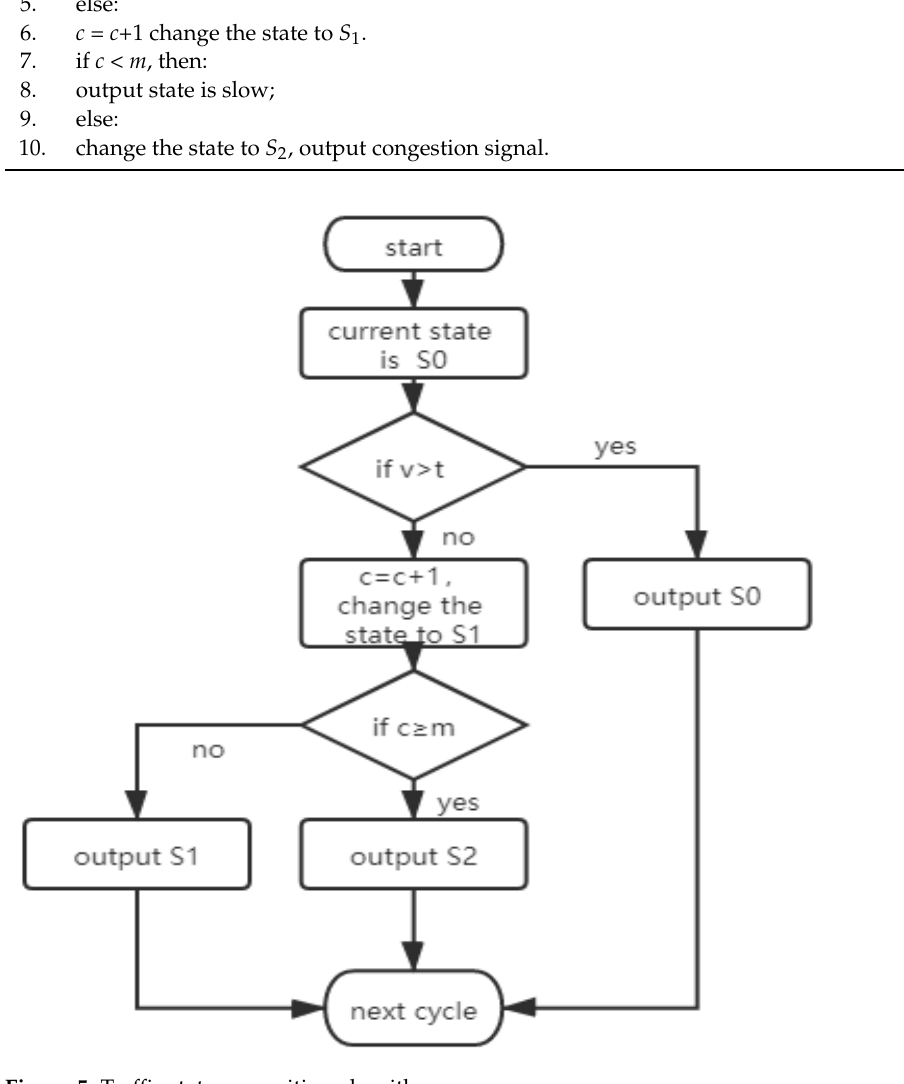
Figure 5. Traffic state recognition algorithm.